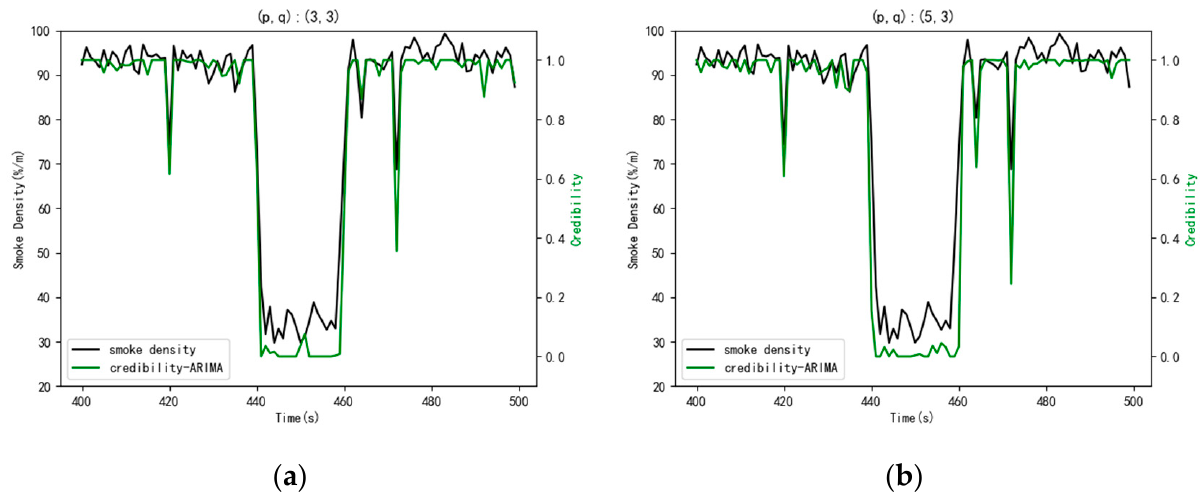
Figure 5. The comparison of the ARIMA model with two different parameters. ( a ) The parameters of ( p , q ) were (3,3); ( b ) the parameters of ( p , q ) were (5,3).